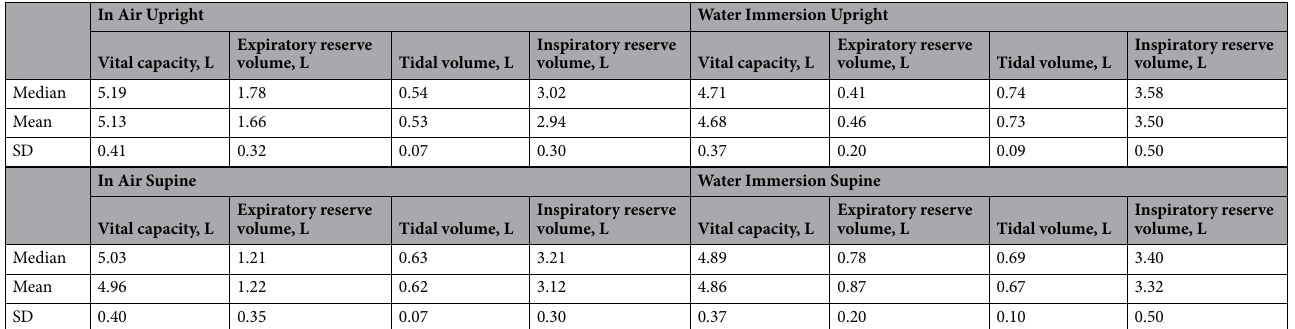
Table 2. Spirometric values measured in each condition. Individual subject values are available in “Supplementary Information” files. Median values are shown with mean and standard deviation. Statistical significance was determined using Friedman’s test (4 conditions) and Dunn’s post-hoc test for each comparison between two conditions. Vital capacity (VC): Friedman p < 0.001; Up-Air vs Sup-Air: NS; Sup-Air vs